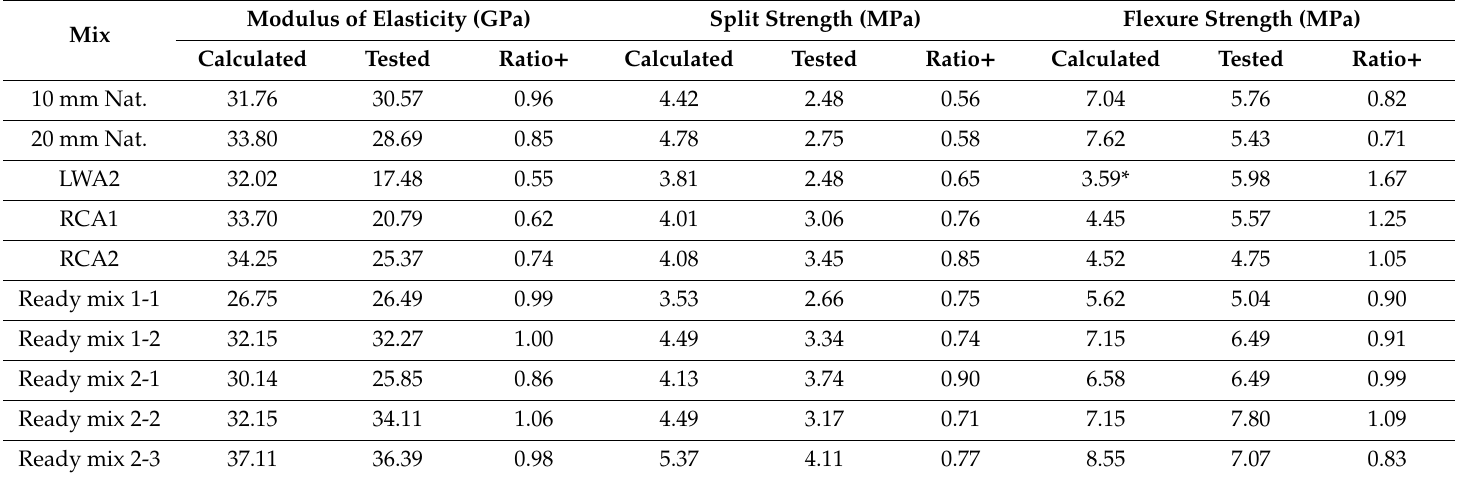
Table 13. Summary of calculated and tested